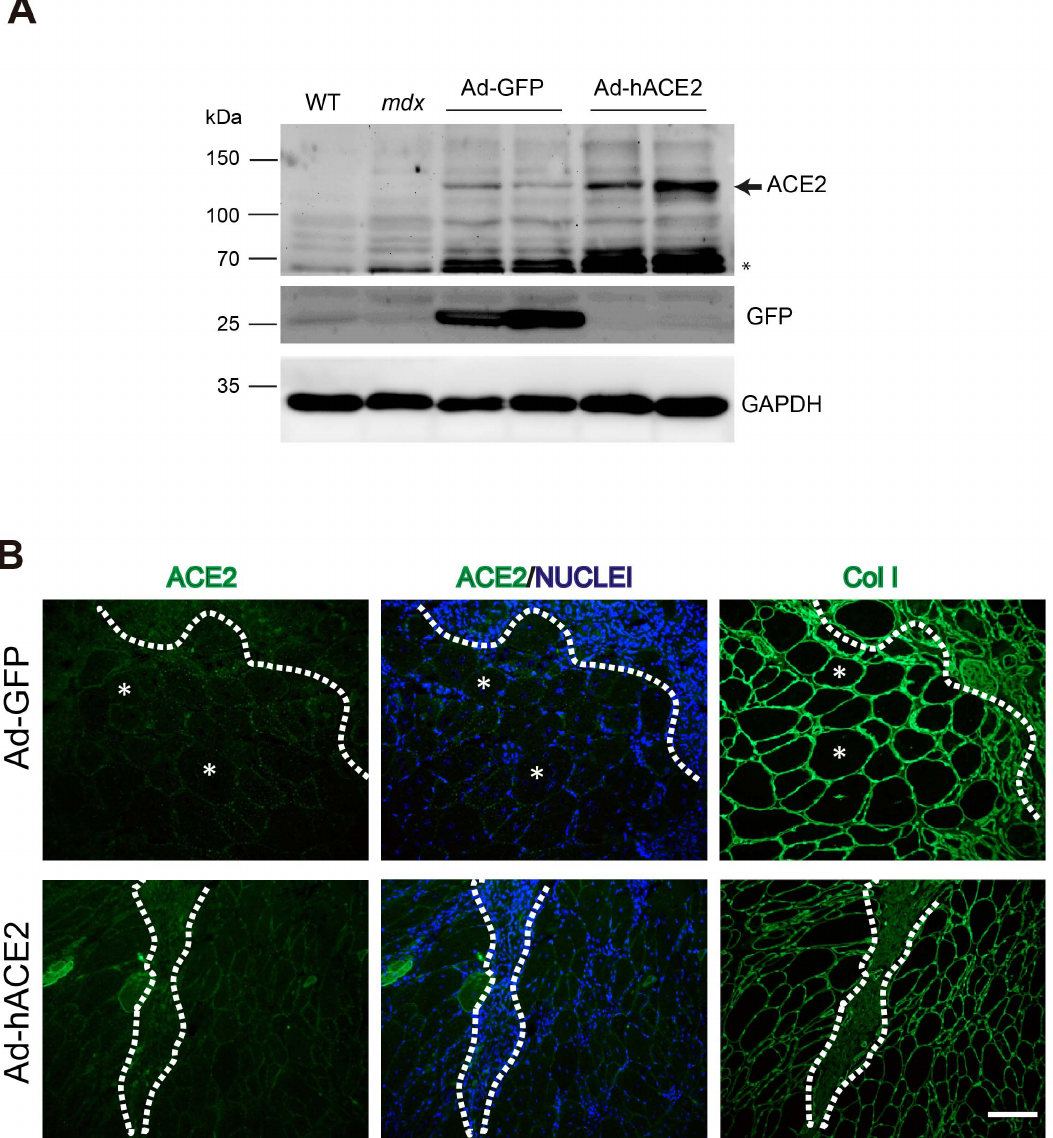
Figure 5. ACE2 overexpression decreases collagen I levels in mdx TA muscle. (A) After 5 days of adenoviral injection, half of the TA muscles were analyzed by western blotting to confirm ACE2 and GFP overexpression. Analysis of wt TA, non-injected mdx TA, Ad-GFP injected mdx TA (n=2), and Ad-hACE2 injected mdx TA (n=2) is shown. The arrow indicates migration of ACE2 and the asterisk (*) indicates a lower molecular weight band detected by the antibody. (B) The other half of the mdx TA muscles from (A) were cryopreserved and analyzed by immunostaining. The upper panel shows serial sections of Ad-GFP injected muscle and the bottom panel sections show Ad-hACE2 injected muscle. ACE2 and collagen I are shown in green and nuclei are shown in blue. The delimitated area marks the injection sites and the asterisks (*) indicate two representative fibers. Bar 50 um.